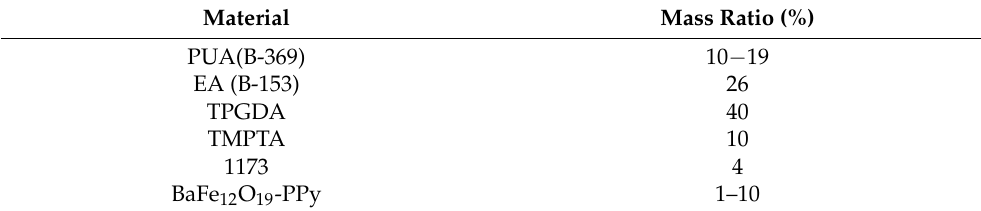
Table 1. Composition of the UV curing